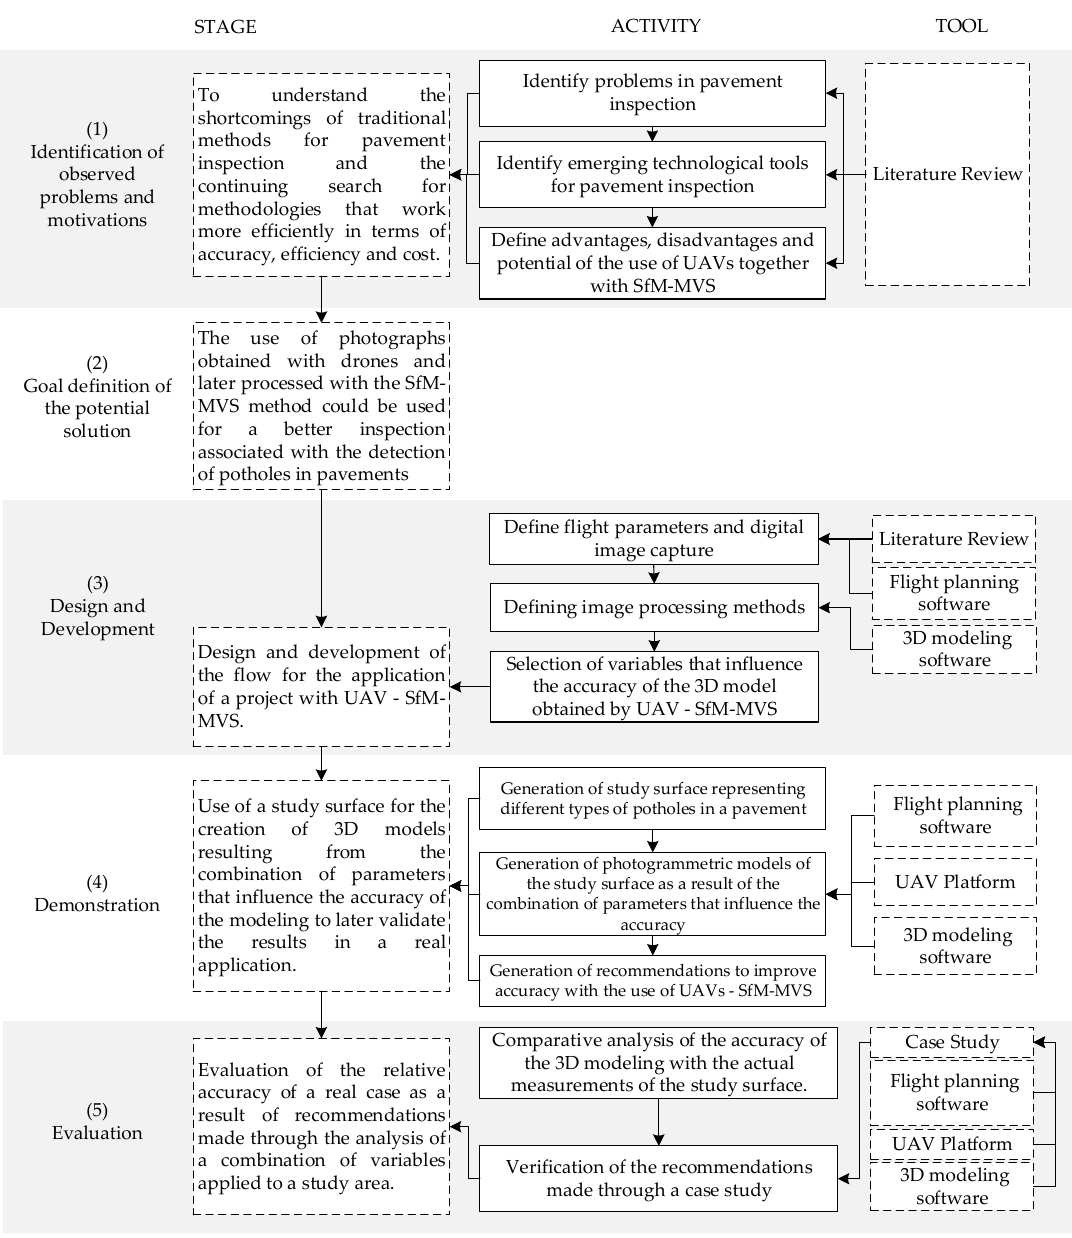
Figure 1. Research Figure 1. Research Methodology.